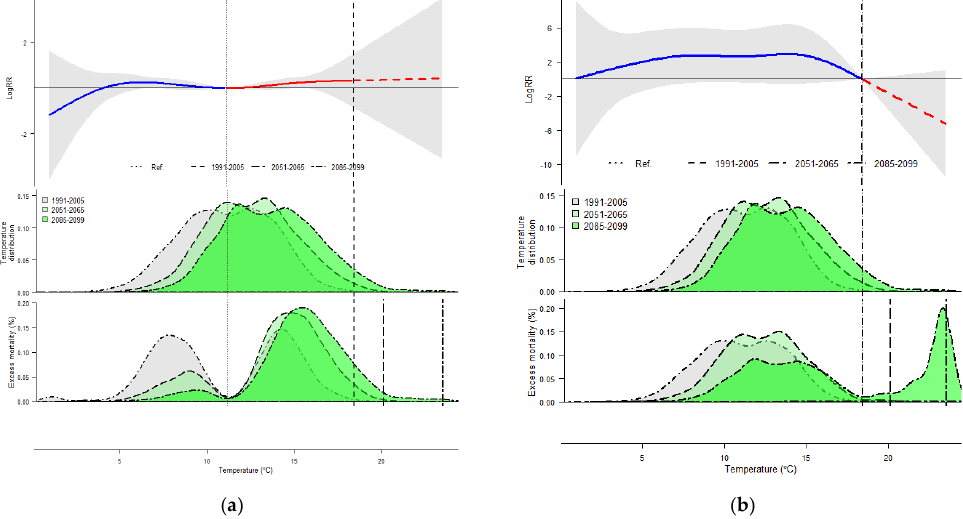
Figure 5. Temperature related mortality and excess mortality for the present and projected future periods in Porto metropolitan area (PMA) during the winter period for people aged <65 years ( a ) and 65+ years ( b ). Top panel: Exposure-response curve for temperature-mortality cumulative associations (logRR). The solid lines represent the logRR and the gray area the 95% empirical confidence interval. The dotted vertical line corresponds to reference temperature (MMT) which divides the curve into cold and hot (blue and red lines, respectively). Middle panel: distribution of the temperature values for the present period, 1991–2005 (grey area) and future periods, 2051–2065 (green area) and 2085–2099 (darker green area). Bottom panel: distribution of temperature-related excess mortality, expressed as the fraction of additional deaths (%) attributed to non-optimal temperature compared with the reference temperature.